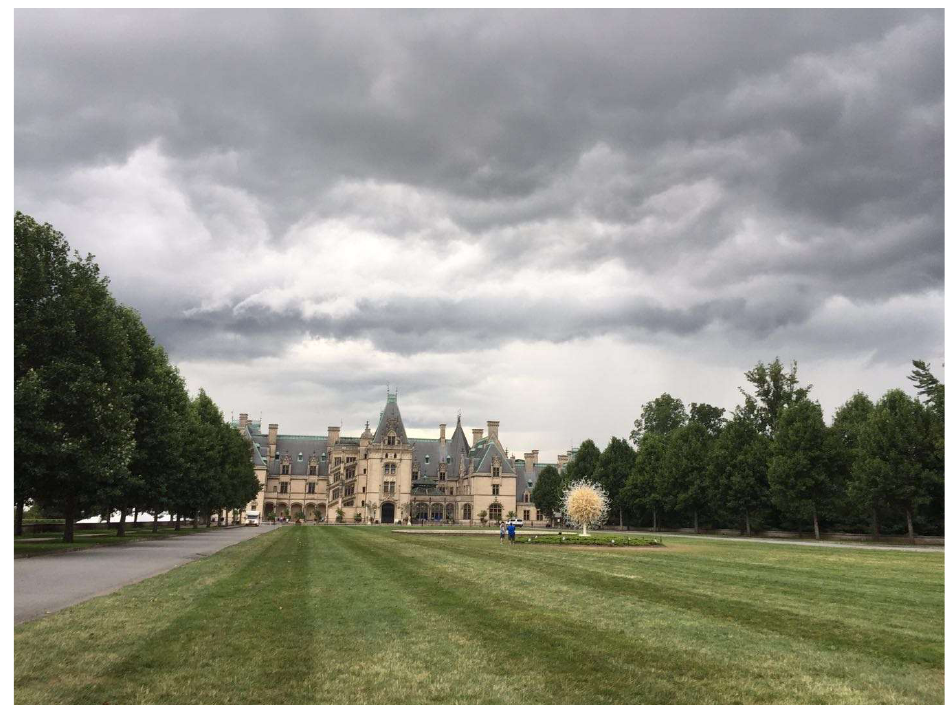
Figure 3. A view from the French Allée at Biltmore, with the Italian gardens to the left of the trees, the English landscape school to the left of the Italian gardens, and the naturalistic Bass Ponds even farther left leading to a river (copyright © 2018 Xiaoying Li, all rights reserved and used with permission).